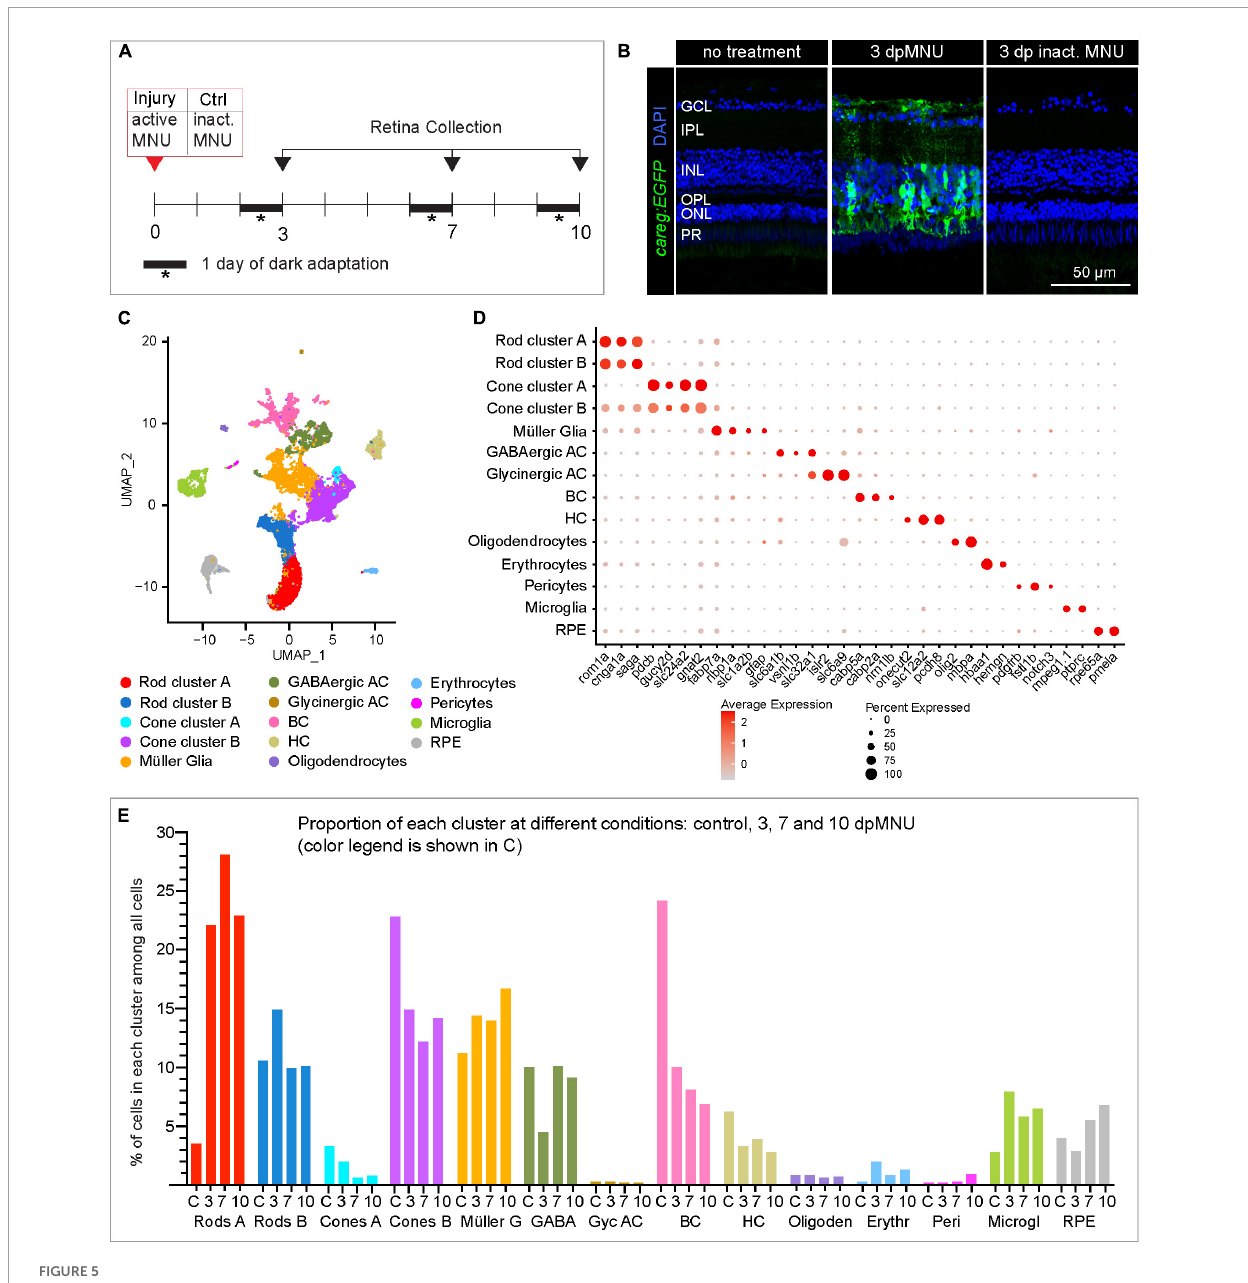
FIGURE5 scRNA sequencing of careg:EGFP regenerating adult zebrafish retinas following MNU chemical injury. (A) Experimental design of retina isolation used for scRNA-sequencing. (B) Transversal sections of uninjured and regenerating careg:EGFP retinas at 3 days after treatment with harmful or inactivated MNU. careg:EGFP expression (green) is not detected after treatment with inactivated MNU, suggesting absence of injury. N = 3. (C) UMAP plots of the integrated cell RNA-sequencing data showing cluster assignments for each cell type collected from control and post-MNU treated retinas. (D) Dot plot showing expression of canonical markers for all retina cell types. Dot size indicates the proportion of cells expressing the corresponding gene and the color gradient indicates the average expression levels. (E) Histogram displaying percentage of cells in each cluster per